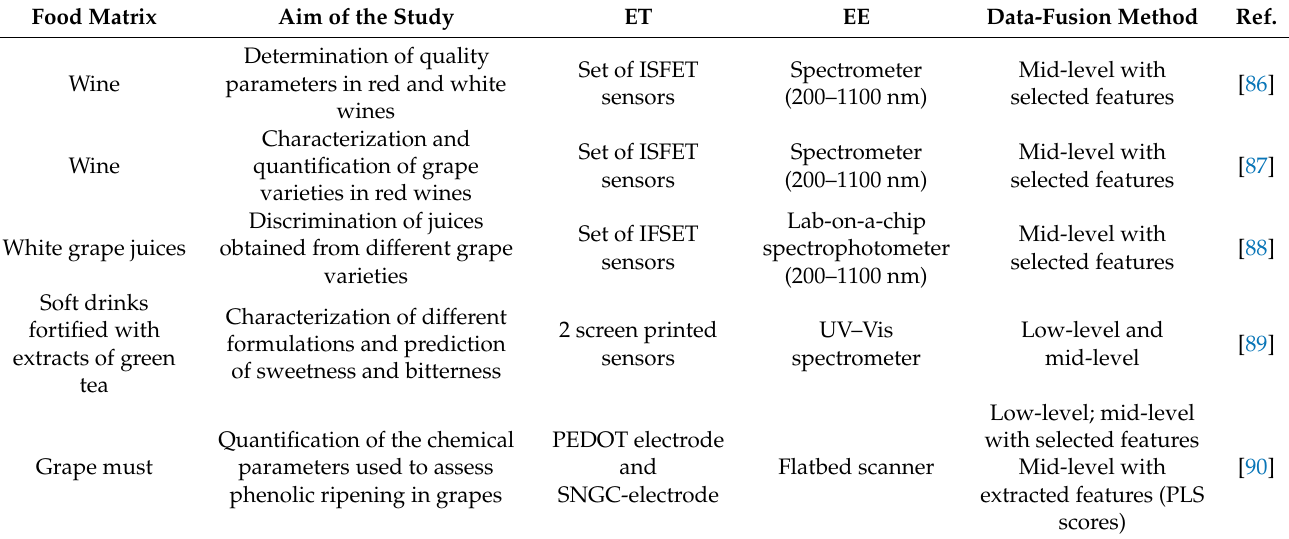
Table 4. List of publications related to the application of combined ET and